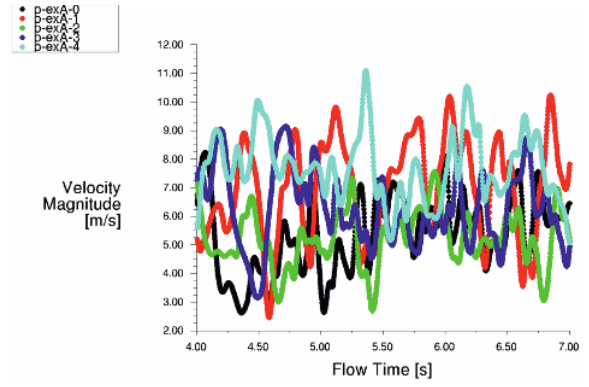
Figure 15: Velocity behavior at the outlet DN1200 pipe